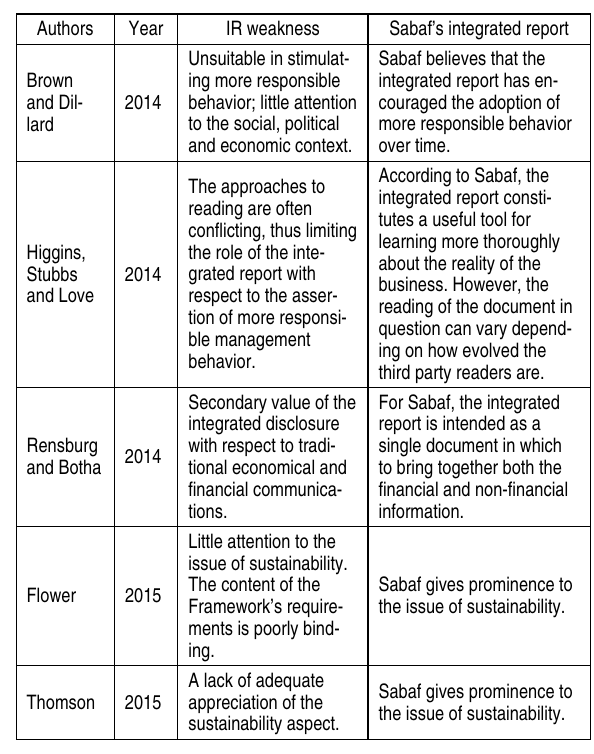
Table 4. Sabaf’s integrated report with respect to the main criticism of the